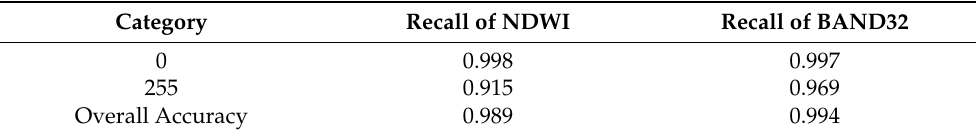
Figure 6. Extraction results of vegetation and partial enlarged image: ( a ) Ground truth information; ( b ) NDVI extraction result; ( c ) BAND48 extraction result. Table 7. Quantitative comparison results of water extraction from the Pavia Center data set.